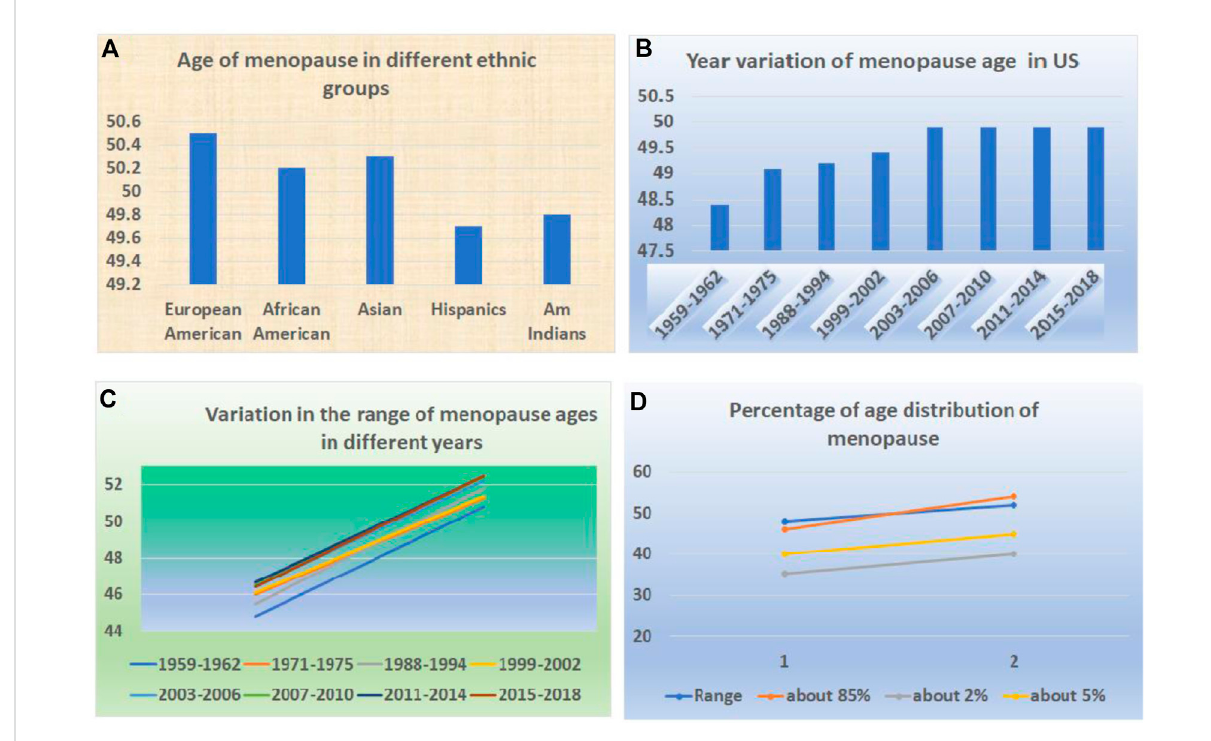
FIGURE 3 Variationofagesatmenopauseinthehumanpopulation. (A) Thevariationsinagesofmenopauseamongdifferentracesandethnicities. (B) The variations in ages of menopause in different years. (C) The variations in the range of ages of menopause in different years. (D) The different percentages of menopause ages among the same